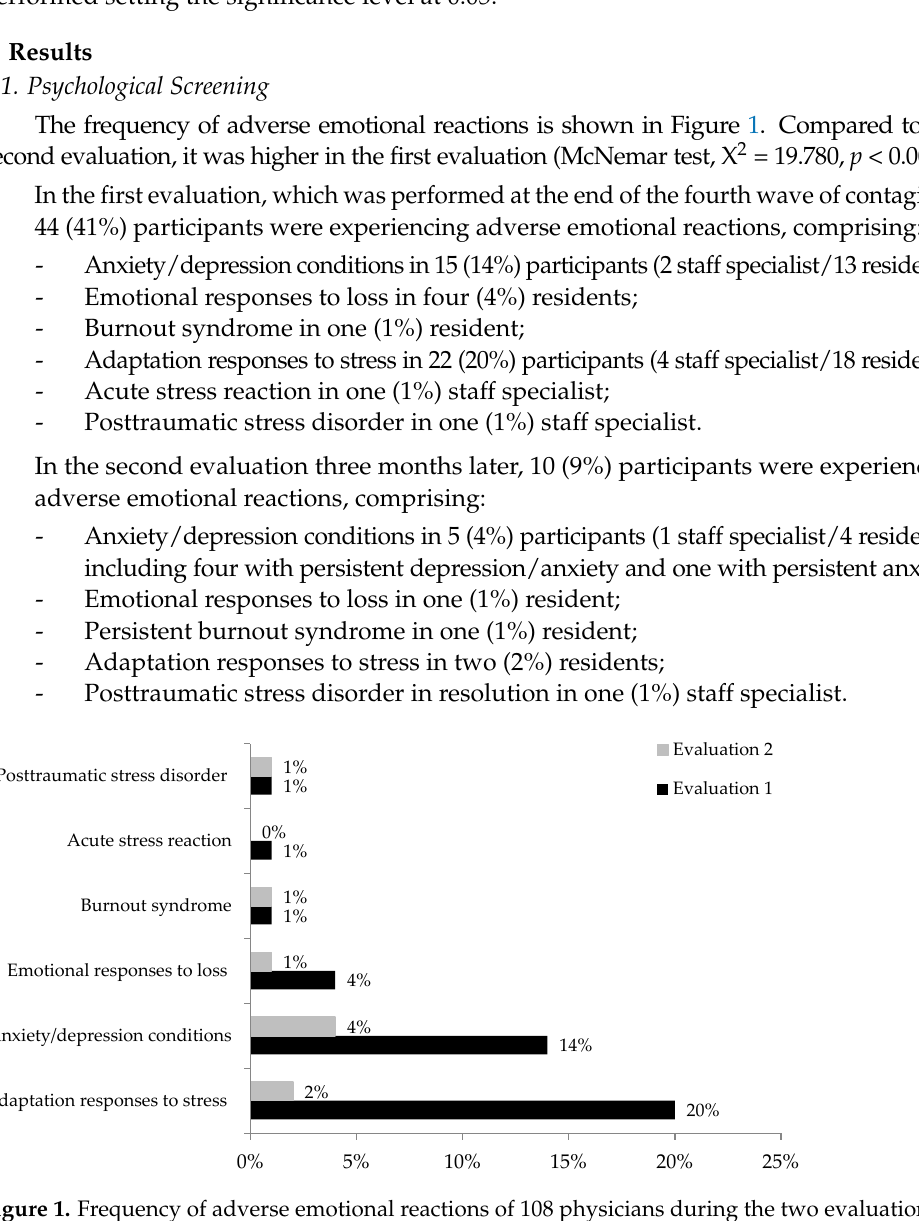
Figure 1. Frequency of adverse emotional reactions of 108 physicians during the two evaluations of the study (with three months in between).